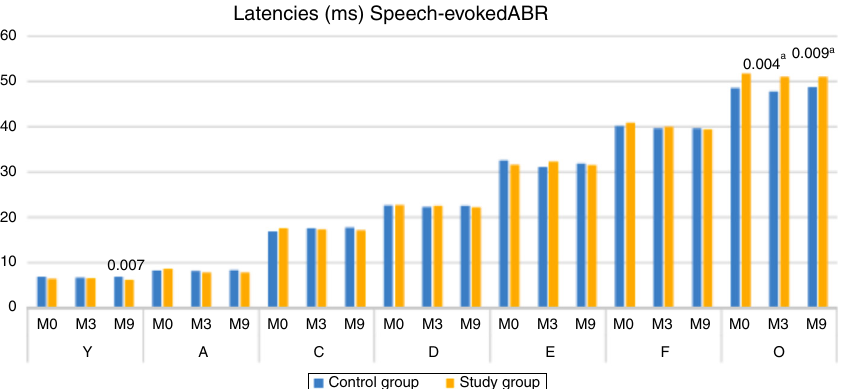
Comparison of Latencies of ABR components with speech stimuli, at moments 0, 3 and 9 months, between the Control and Study Groups---Mann---Whitney. a Statistical significant difference decrease in the latency of component A in the SG (M9) and the lower latency of component V in the SG (M9), reinforce the occurrence of neuronal plasticity, verified in the improvement of the electrophysiological response after 9 months of auditory stimulation with the hearing